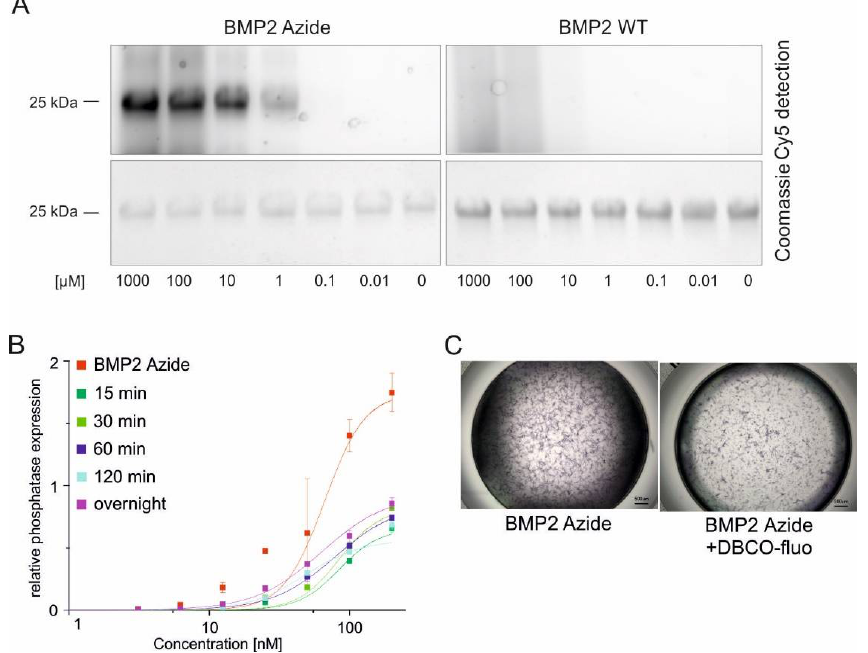
Figure 2. Proof of coupling specificity and maintained bioactivity after a copper-free reaction of BMP2 Azide with a DBCO-functionalized fluorophore. ( A ) BMP2 Azide (20 µ M concentration) was coupled to different concentrations of a DBCO-functionalized fluorophore (DBCO-Cy5). Coupling